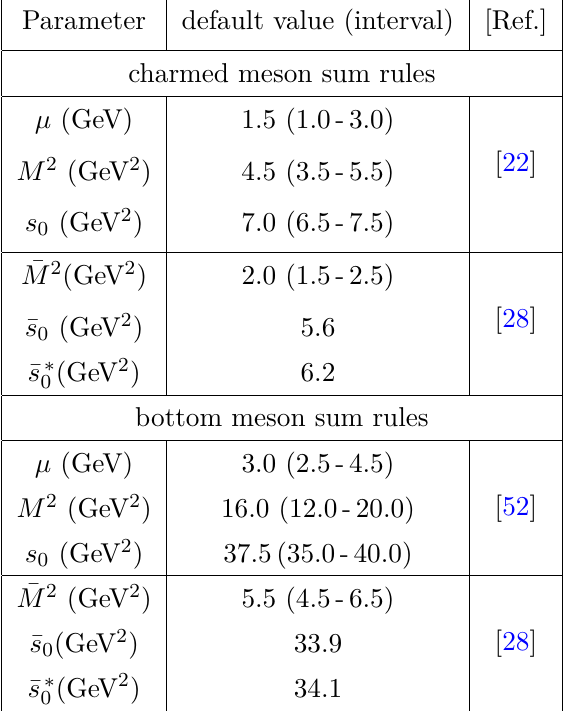
Table 3 . The renormalization scale µ , Borel parameters M 2 and and ¯ s ( ¯ s ∗ ) used, respectively in the LCSR and the two-point sum rules for the H ( H ∗ ) decay 0 0 constants for both charmed and bottom